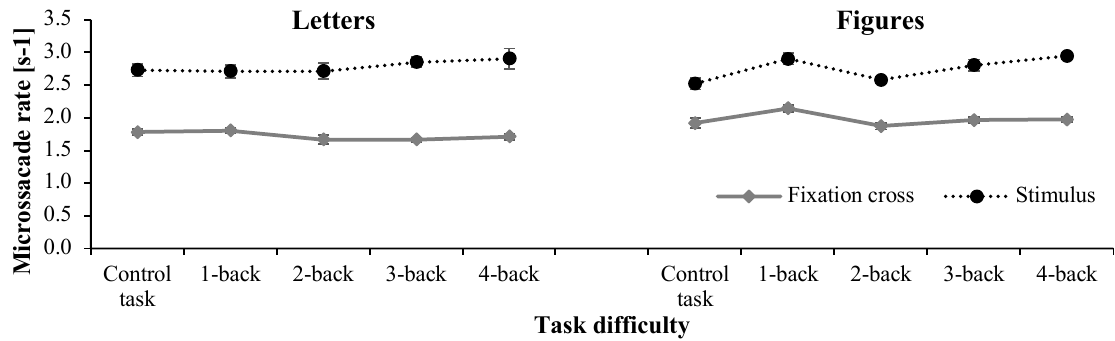
Figure 5. Means and standard errors for microsaccade rate per second as a function of n-back level (mental load) and dis- played stimulus (fixation cross vs stimulus) for each stimulus type (visual